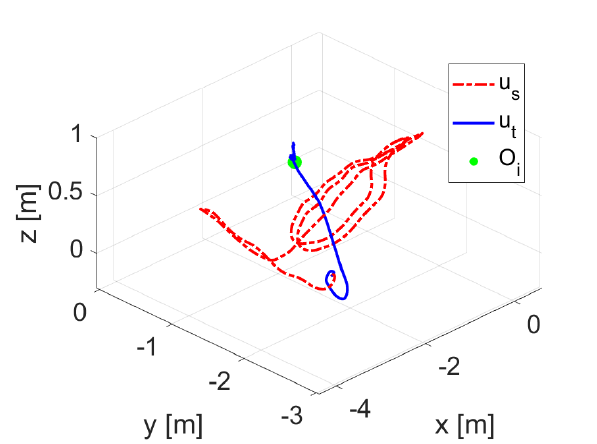
Figure 14. Trajectories obtained by u s and u t for the AUV of F t , where, in the target dynamics, one thruster is damaged and another reverses its rotating direction.